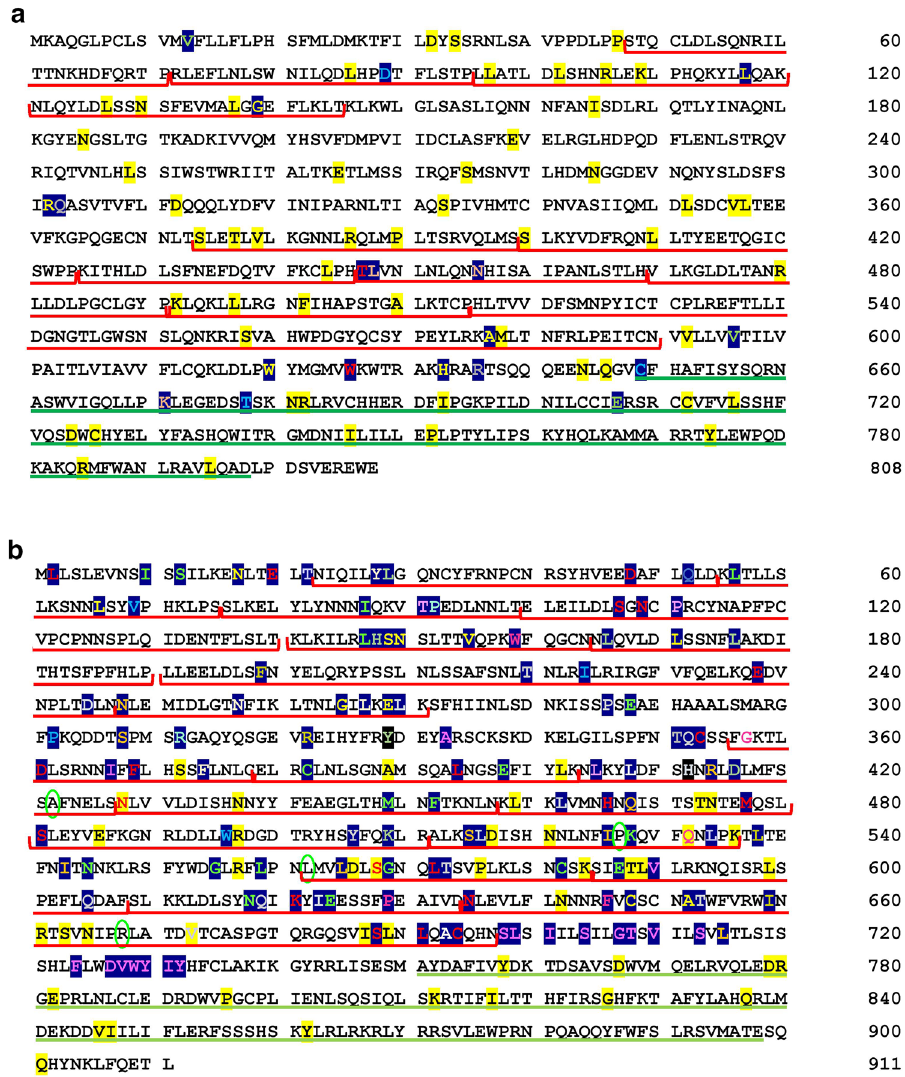
Figure 7. Representation of positively selected and co-evolved sites on the C. batrachus TLR1 ( a ) and TLR7 ( b ) amino acid sequences. The LRR domains detected via LRRfinder (http://www.lrrfi nder.com/lrrfi nder.php) are demarcated with red square brackets under the sequence and the TIR domain has been underlined in green. The residues under positive selection and co-evolution have been highlighted in yellow and blue, respectively. The various colored alphabets highlighted in blue denote the co-evolving residues from the same cluster. The residues experiencing both positive selection and coevolution are encircled in green. The figure depicts the nestling of positively selected and co-evolved sites within the functional domains (LRR, TIR) of the